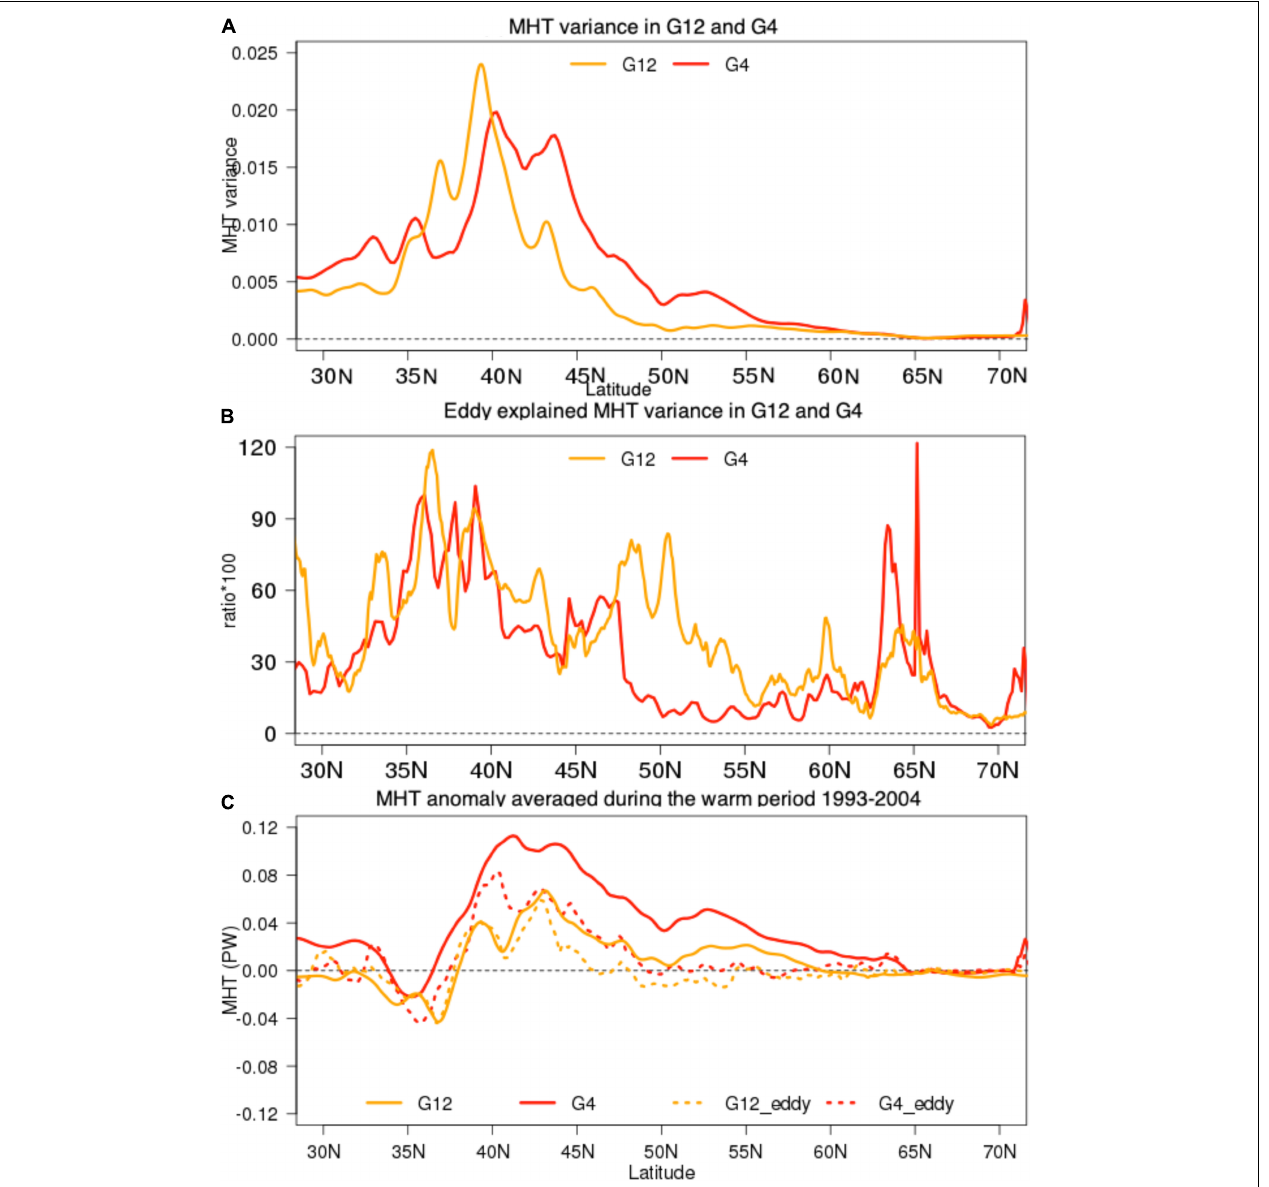
FIGURE 7 | (A) The temporal variance of MHT anomalies in G4 and G12 (B) Eddy explained MHT variance in G4 and G12 calculated as shown in Equation 8. The values have been multiplied by 100. (C) MHT anomalies averaged for the warm period (1993–2004) and the contribution from meso-scale